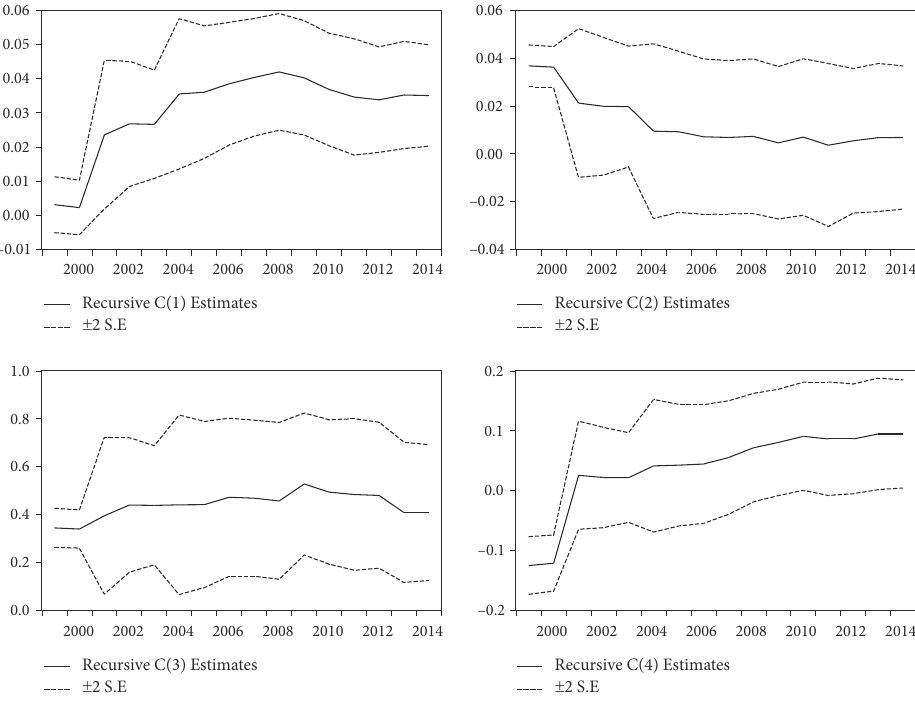
Figure 9. Recursive coefficient estimates for Equation (14) (source: authors’ own processing)